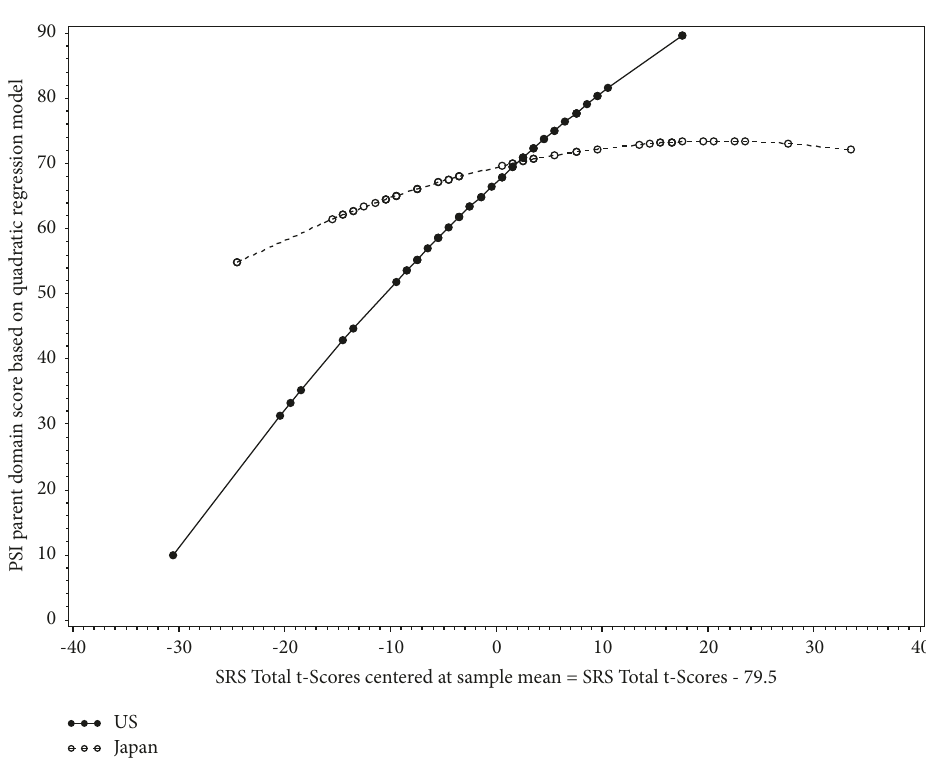
Figure 6: (a). Difference between the U.S. and Japan with respect to the quadratic association between the parenting stress index (PSI) total score and the social responsiveness scale-2 (SRS-2) total t-score centered at sample mean. Note: (a) is a graphical display of the following fitted quadratic regression model: “mean (maternal stress level based on parenting stress index total score)” � “87.52 + 0.97 × (SRS-2 t-score − 79.5) − 0.05 × (SRS-2